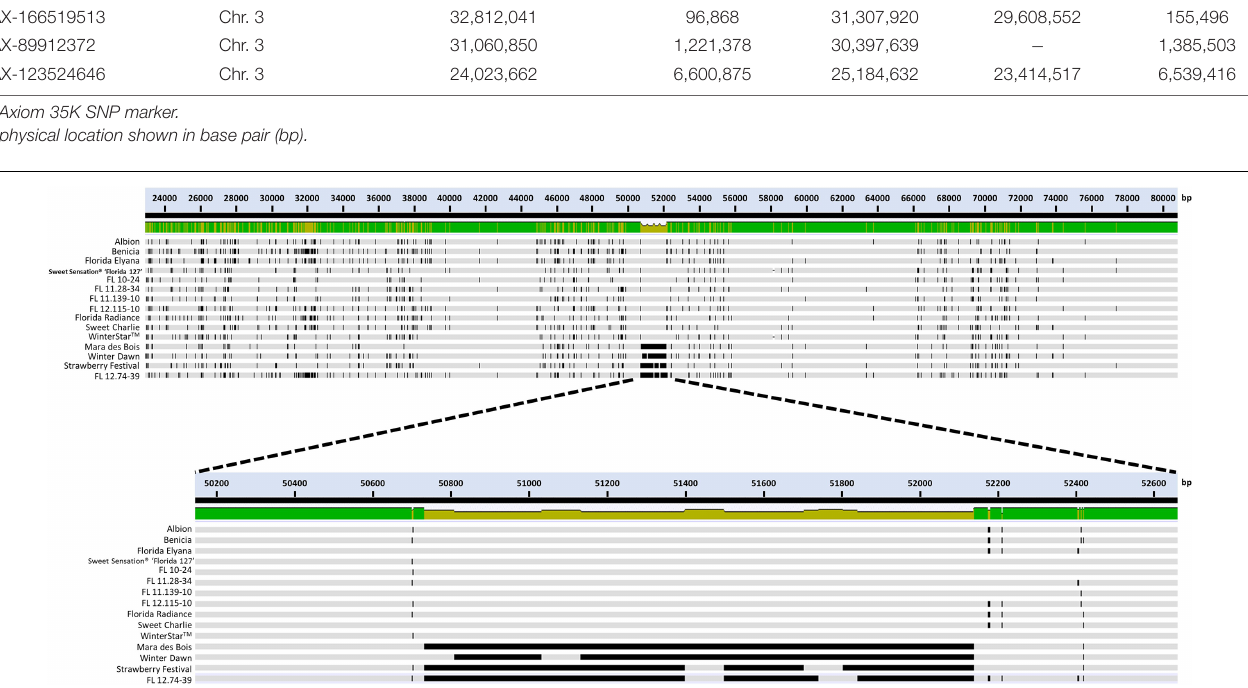
region is directly related to the production of γ -D in the octoploid